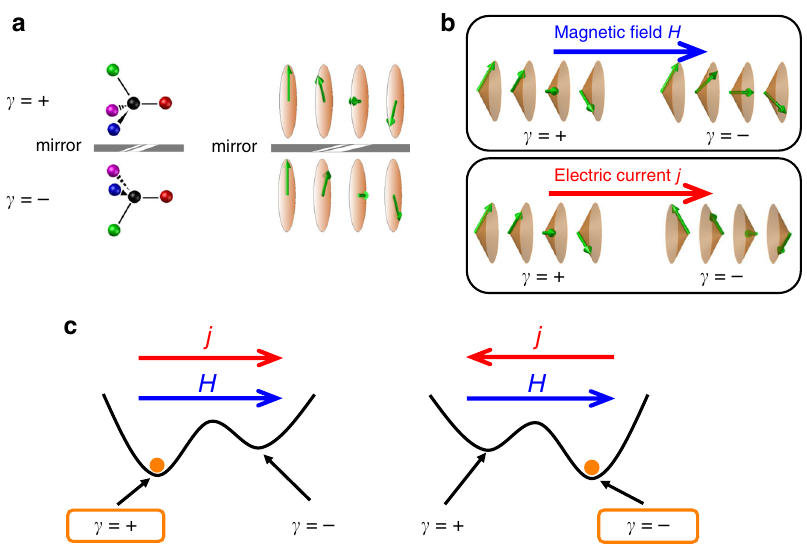
Fig. 1 Electric current control of helicity in an itinerant longitudinal spiral magnet. a Illustrations of chiralities of molecules and spiral magnets. γ = ± denotes the chirality (helicity). b Illustrations of the magnetic structure of spiral magnets in the presence of a magnetic fi eld or electric current. In the presence of a magnetic fi eld, the magnetic moments are tilted to the fi eld direction, forming a conical magnetic structure. The net magnetization is along the magnetic fi eld, irrespective of the chirality. The electric current along the propagation vector also induces the conical magnetic structure. In this case, the net magnetization direction is dependent on the chirality. c Illustrations of the electric current control of helicity in a longitudinal spiral magnet. The energetically favored helicity in the presence of magnetic fi eld H and electric current j depends on whether they are parallel or antiparallel to each